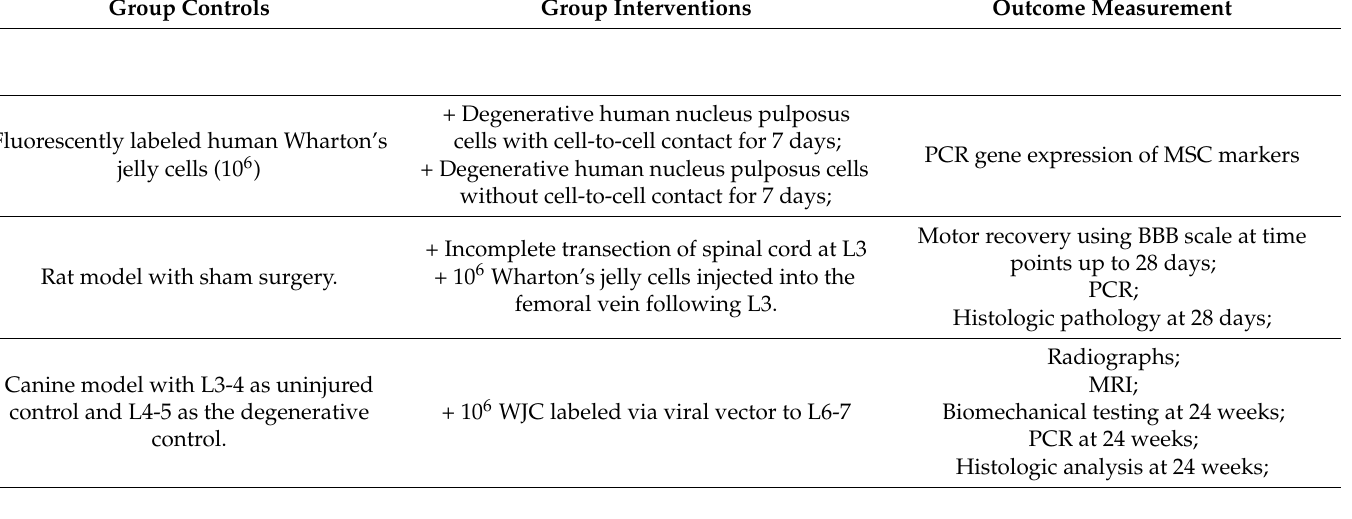
Table 1. Summary of articles that met selection